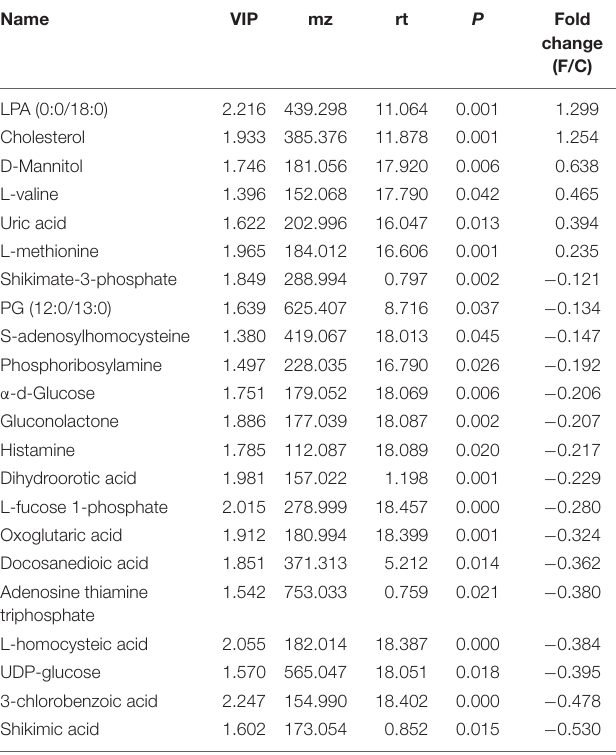
TABLE 2 | Differential BALF metabolites on 3